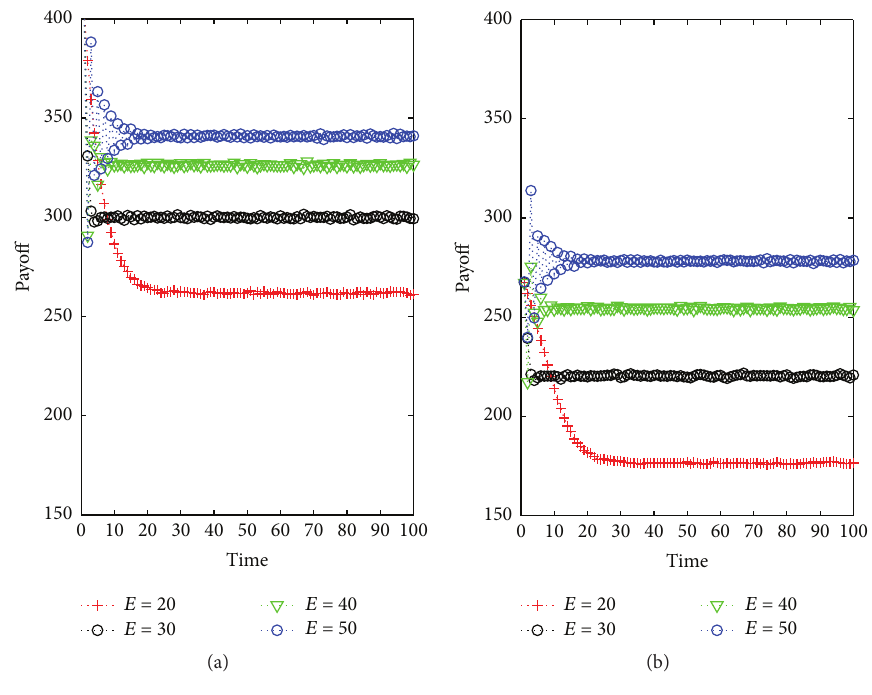
Figure 7: The payoff for (a) greedy and (b) altruist.